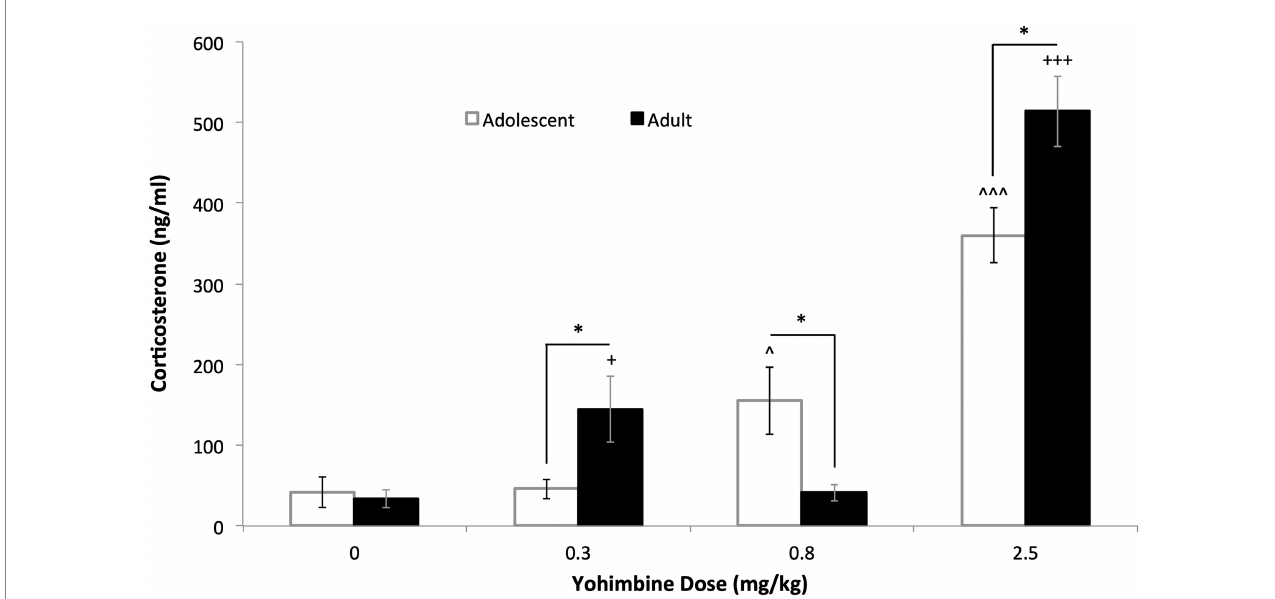
FIGURE 2 Age differences in yohimbine-induced plasma corticosterone secretion. The bars represent mean (±SEM) corticosterone levels after yohimbine injections for adolescent (white bars) and adult (black bars) rats. The α 2 AR antagonist, yohimbine (0, 0.3, 0.8 and 2.5 mg/kg, i.p.) was given 1 h before trunk blood was collected and analyzed for corticosterone levels. ^ p < 0.05, ^^^ p < 0.0001 vs. 0 dose, adolescents; + p < 0.05, +++ p < 0.0001 vs. 0 dose, adults; * p < 0.05 vs. adult. n = 7–10 per group.